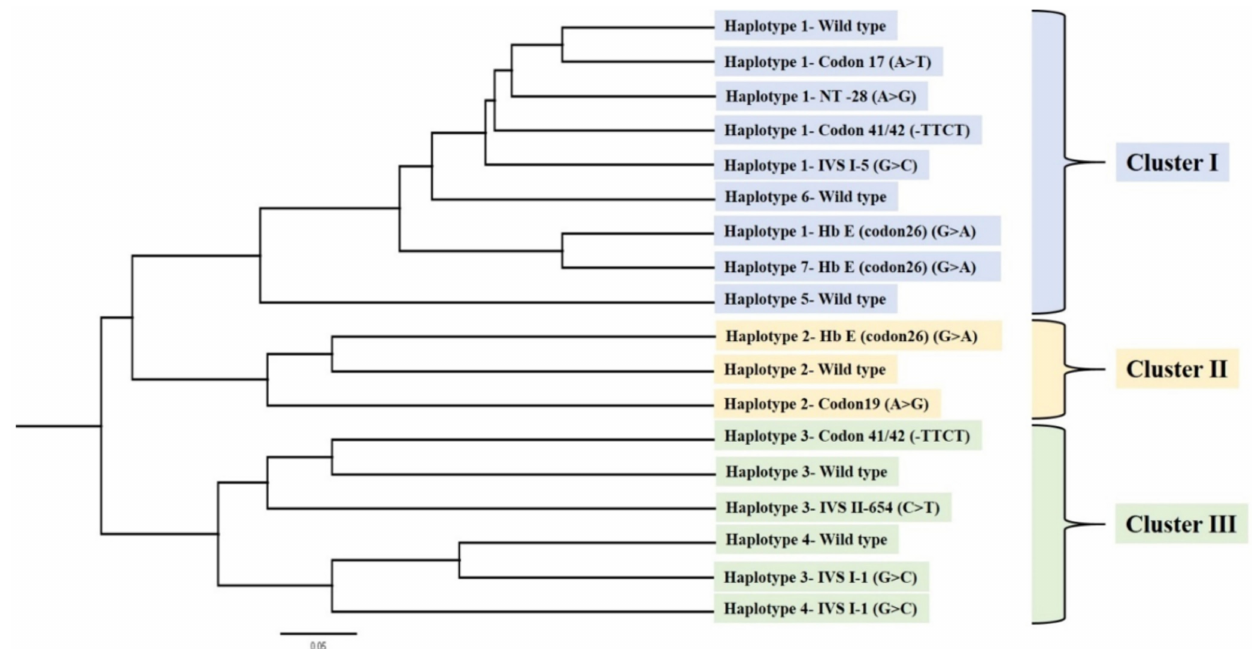
Figure 2. Phylogenetic tree based on haplotype data, constructed using DendroUPGMA software (http://genomes.urv.cat/UPGMA/, accessed on 5 May 2022) with application of the Jaccard (Tani- moto) coefficient, cophenetic correlation coefficient (CP) 0.8148 and the distance matrix based on the Jaccard (Tanimoto) coefficient with 100 bootstrap replicates